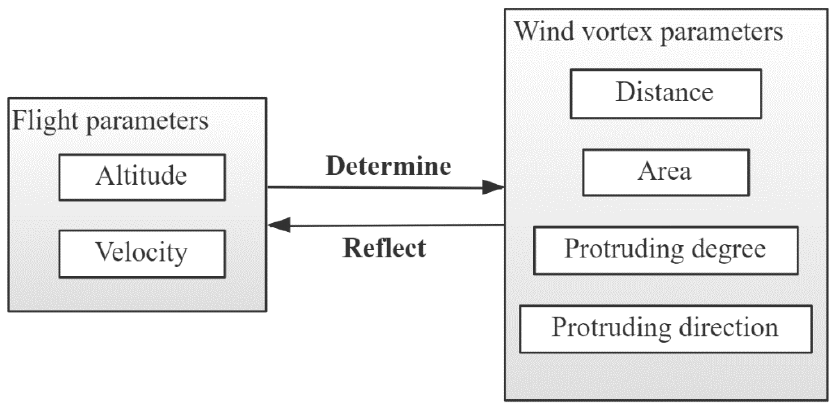
Figure 13. Relationship between flight parameters and wind -vortex parameters.